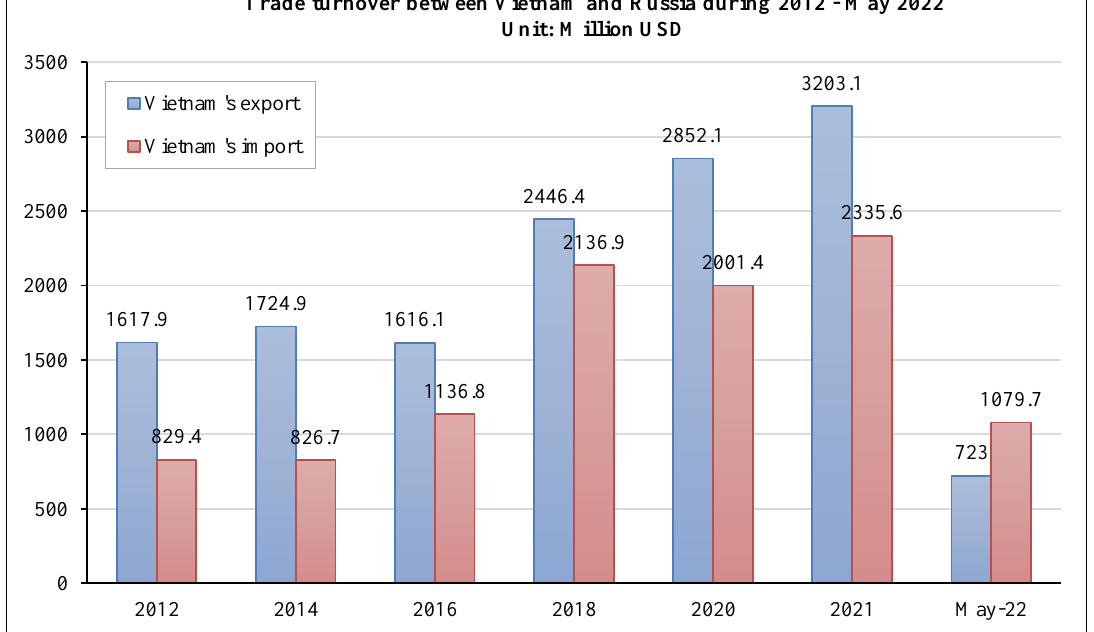
Figure 3. Trade turnover between Vietnam and Russia during 2012 - May 2022 ( Unit: Million